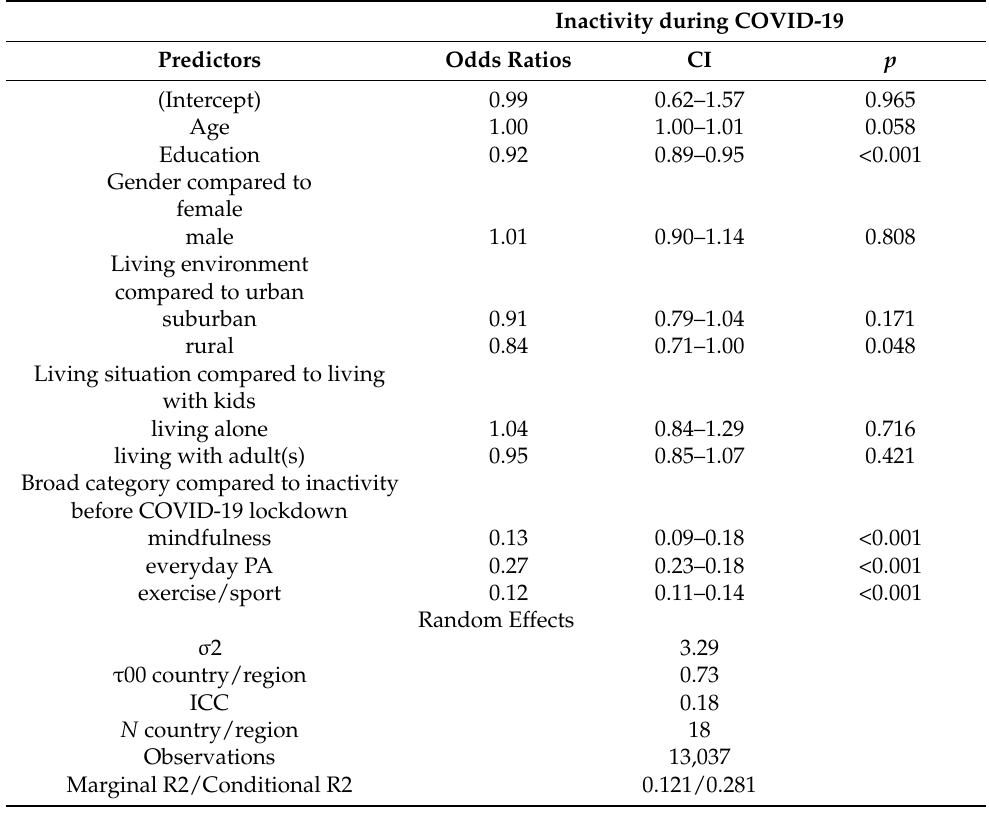
Table 2. Mixed logistic regression model predicting inactivity during the initial COVID-19